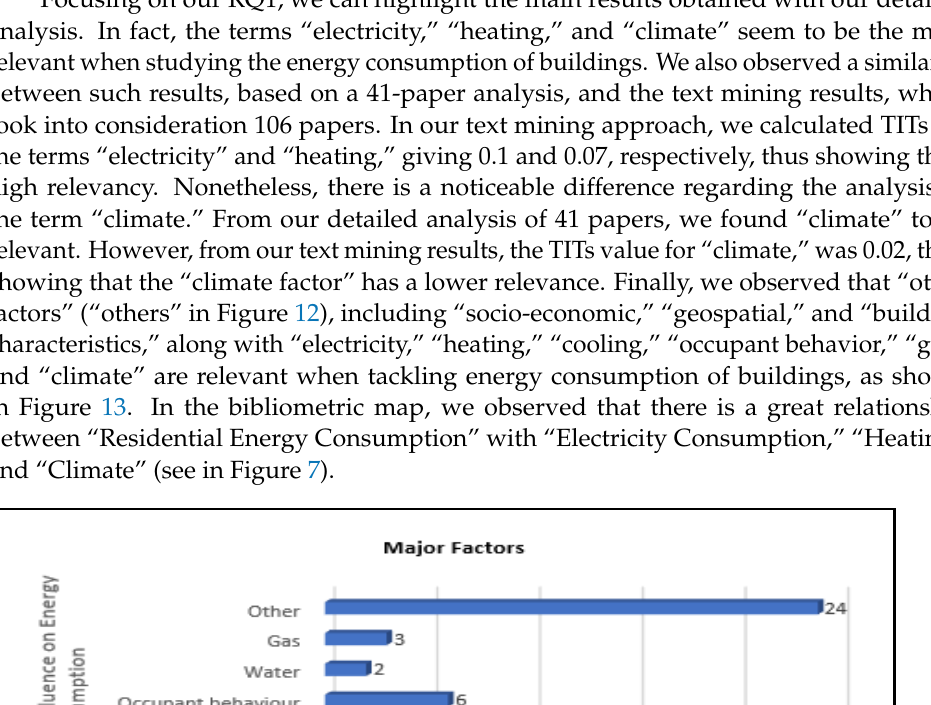
Figure 14. Top classification techniques identified in our survey.